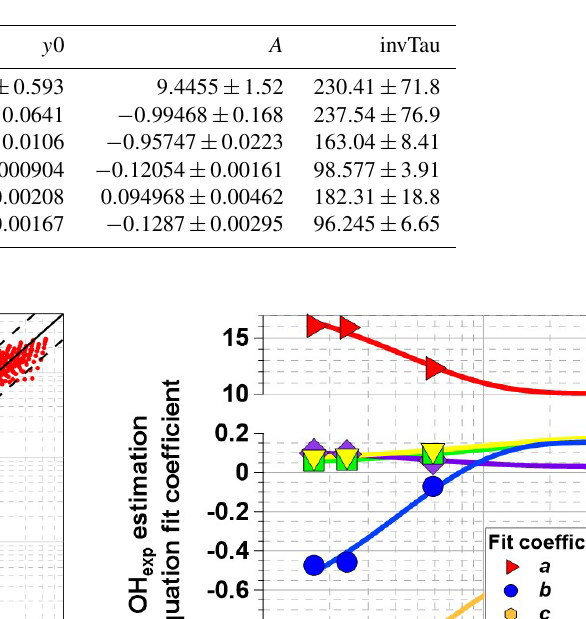
Table 3. Parameterization of Eq. (1) coefficients ( ± 1 σ ): y 0 + A × exp [ I 185 : I 254 ) × invTau ] .